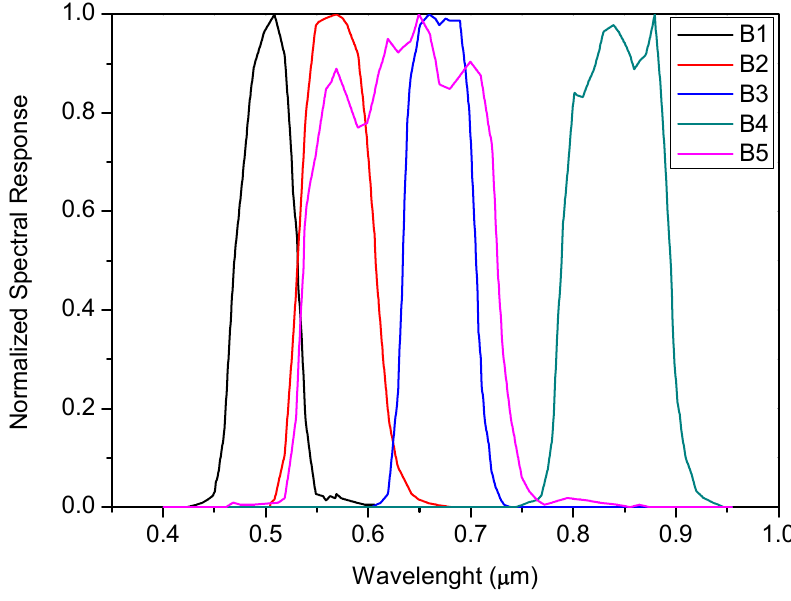
Figure 1 . CCD/CBERS-2B normalized spectral